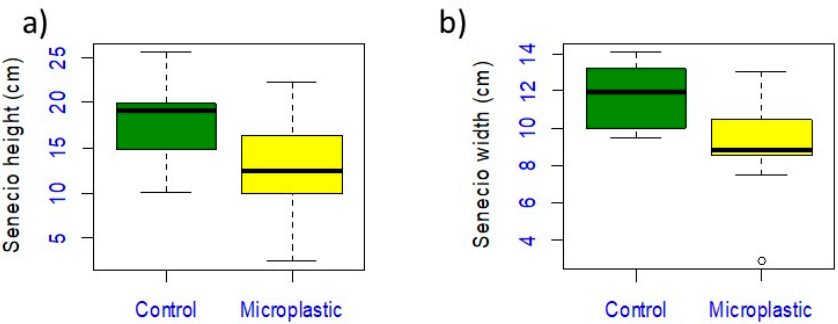
Figure 6. Plant height ( a ) and width ( b ) of S. inaequidens in the control and microplastic treatment. Photosynthesis . Photosynthetic ability, expressed as the index Fv/Fm, did not differ significantly between treatments (Supplementary Material )